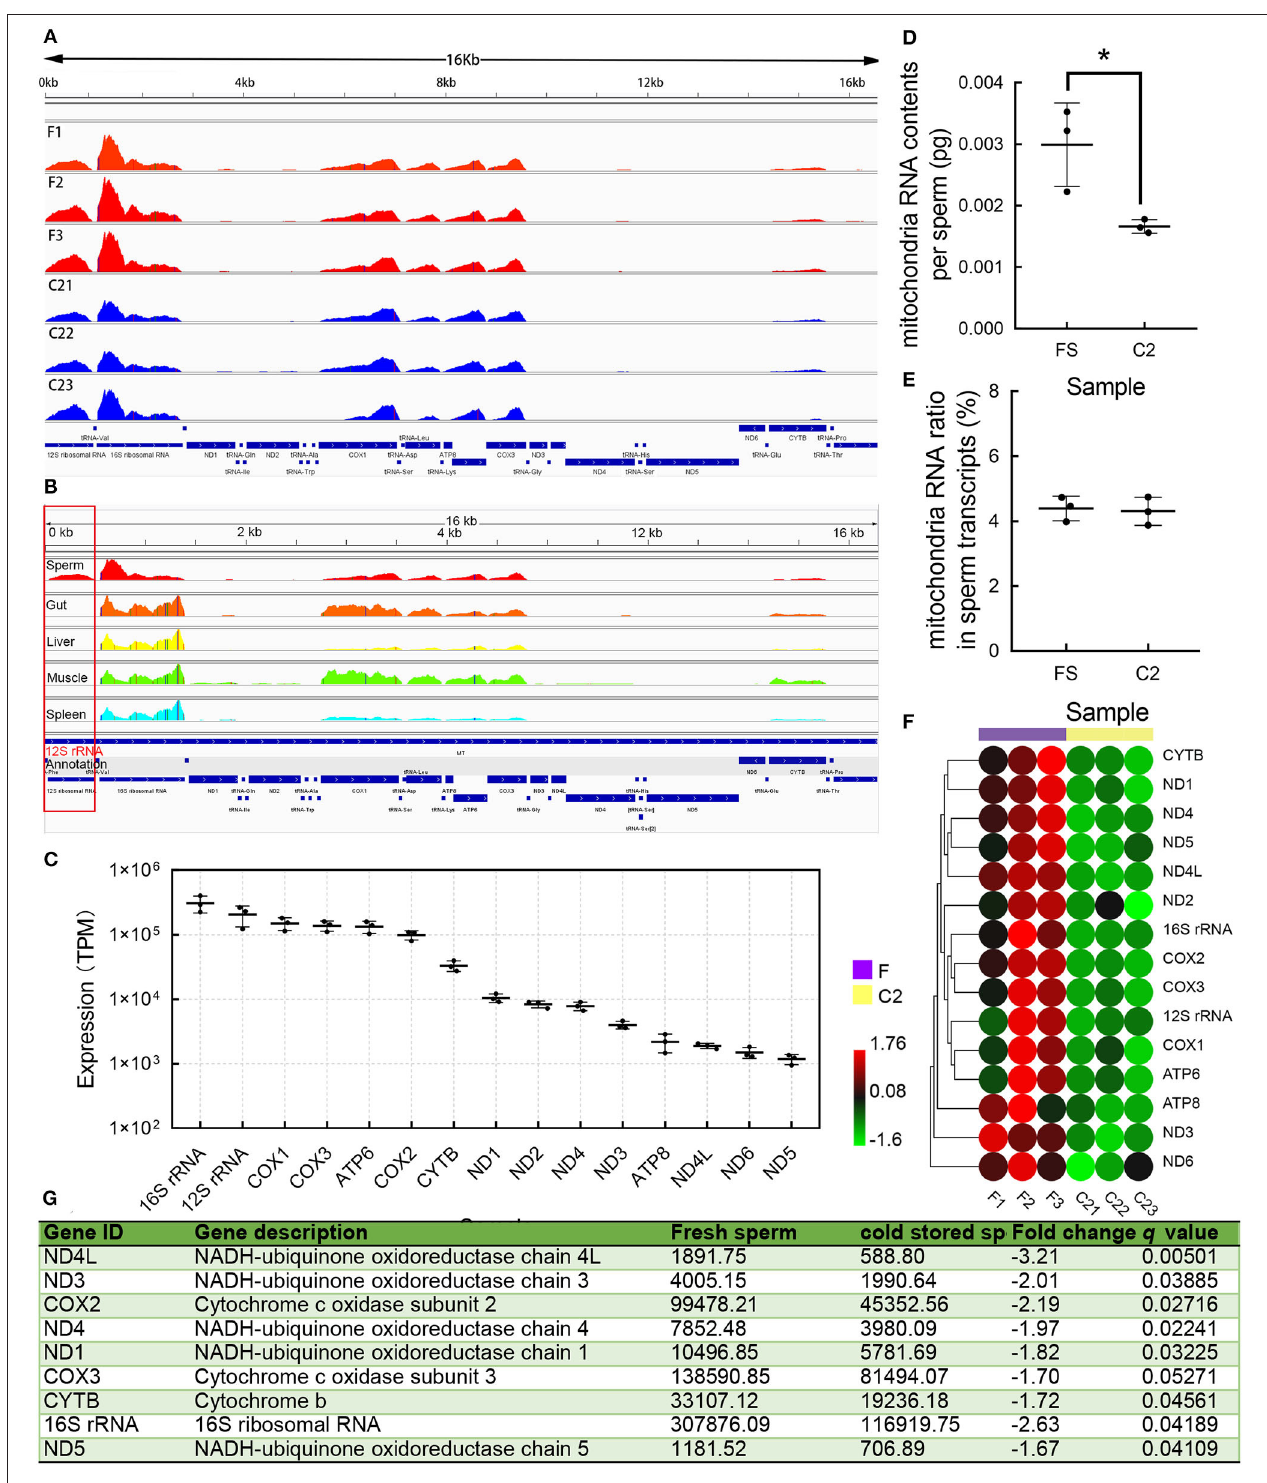
FIGURE 4 | The components and changes of mitochondrial transcript. (A) The expression profiles of mitochondrial messenger RNA (mRNA). (B) The expression profiles of mitochondrial mRNA in sperm and other tissues in the giant grouper. The 12s rRNA showed a high expression level in sperm and low expression levels in other tissues. (C) The expression levels of mitochondrial mRNA. (D) The mitochondrial mRNA contents per sperm. (E) Mitochondrial mRNA ratio changes and whole mRNA ratio change. (F) The heatmap of mitochondrial mRNA during cold storage. (G) The differentially expressed transcripts during cold storage. Asterisk indicated significant difference ( p <